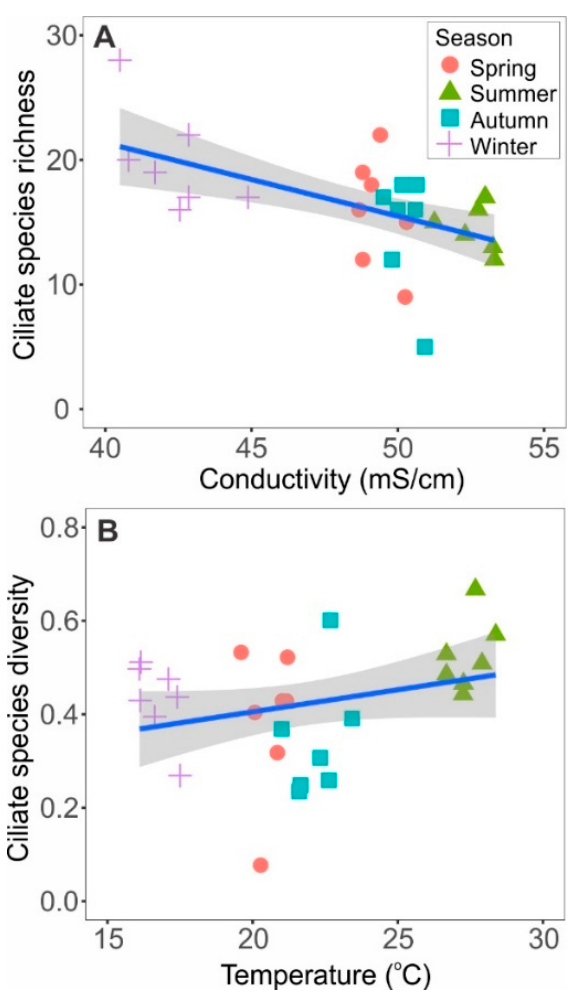
Figure 9. Relationships between benthic ciliate community descriptors and environmental variables. ( A ) Species richness (number of species) and conductivity. ( B ) Species diversity (Simpson’s 1-D) and temperature. Sampling plots identified according to season.